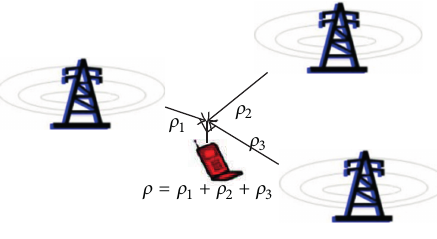
Figure 1: Coordinated multipoint.